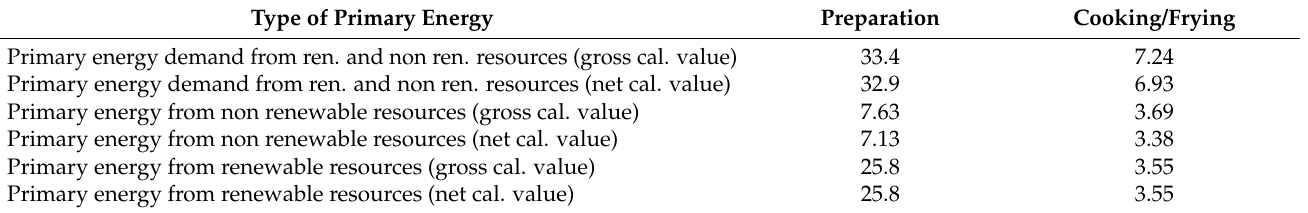
Table 3. Primary energy values in the preparation and cooking/frying phases in MJ (functional unit: one portion